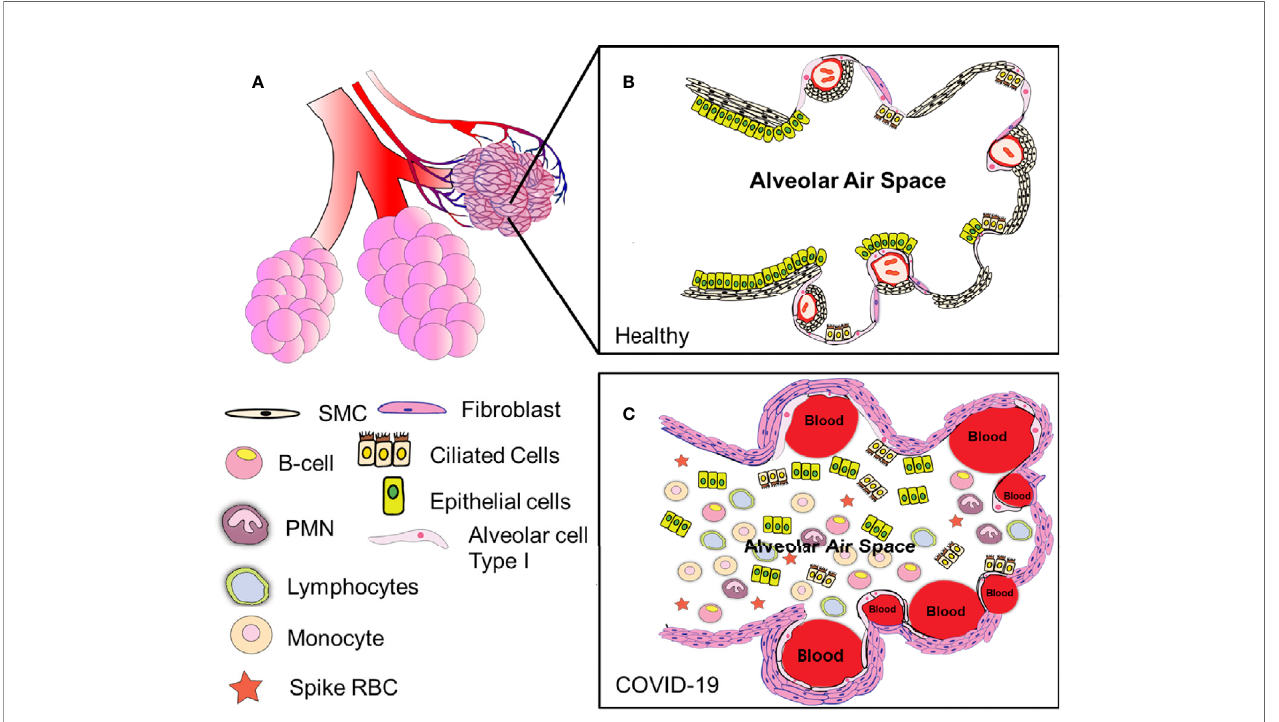
FIGURE 12 | Summary of our fi ndings. Our data indicate that COVID-19 is a highly heterogeneous disease with multiple etiologies (A) Correspond to a representation of the alveolar sacs. (B) Ampli fi cation of the alveolar area to denote the organization of the lung in healthy conditions. (C) Correspond to the lung organization in COVID-19 conditions, including enhanced coagulation (intravascular and parenchymal), fi broblast proliferation, loss of epithelial, ciliated, and SMC, as well as endothelial cells from the alveoli. Several questions remain about the immune response, including the lack of immune organization around lesions (as indicated in phenotype 1), the strong B cell response in the lung that could not control the infection, and associated damage. The lack of viral mRNA in the lung and the abundance of protein M inside the blood vessels suggest replication in other tissues. The presence or absence of hemorrhagic events and the formation of fi brin webs inside the blood vessels. All these different phenotypes provide several opportunities to reduce or prevent the devastating consequences of